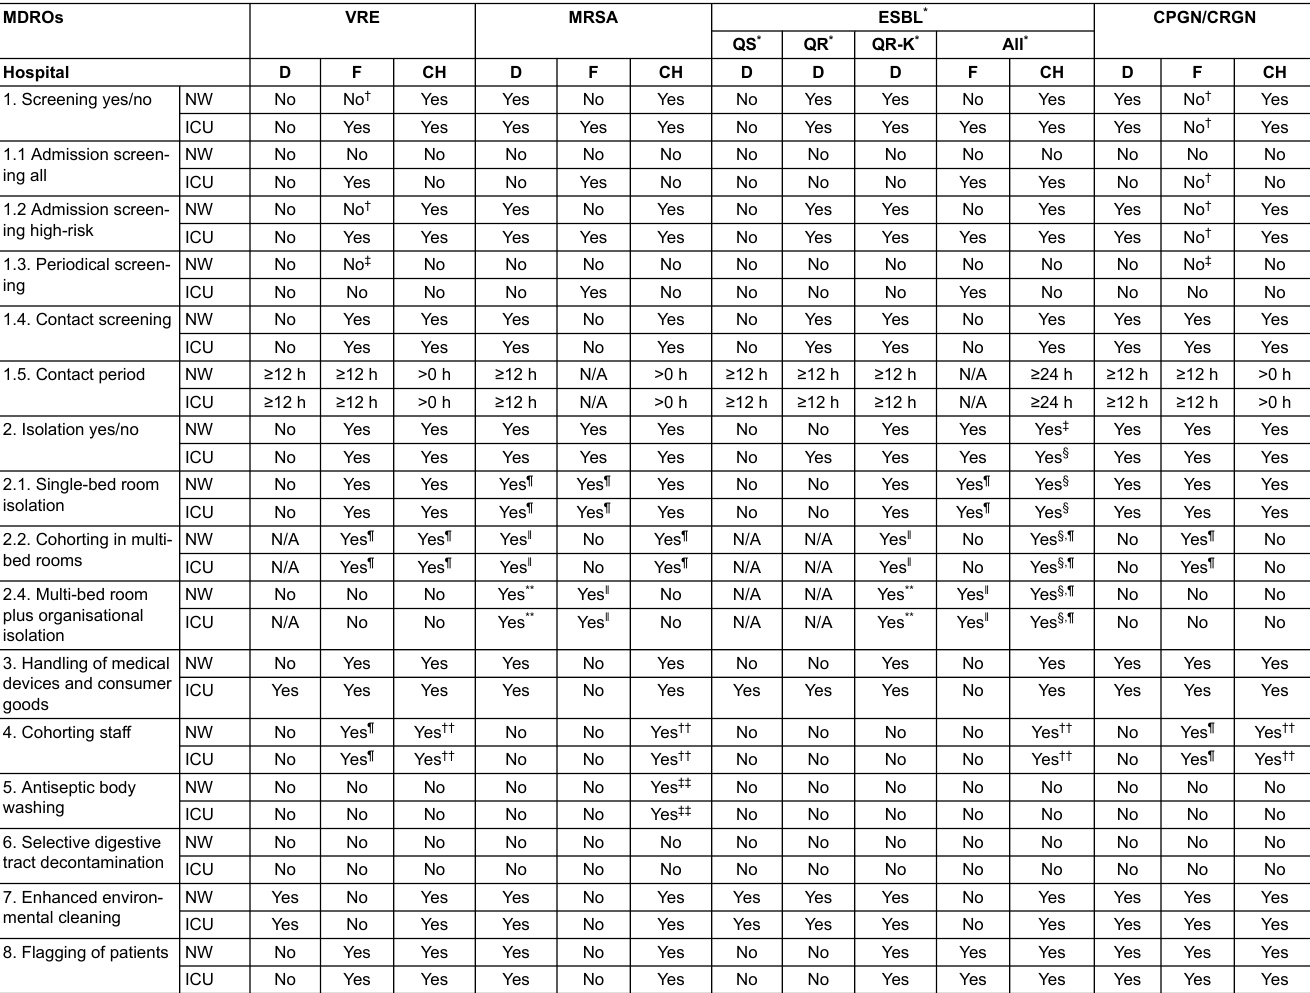
Table 3: Measures to control infection with multidrug-resistant organisms (MDROs) in Germany-France-Switzerland tristate area. MDROs VRE MRSA ESBL